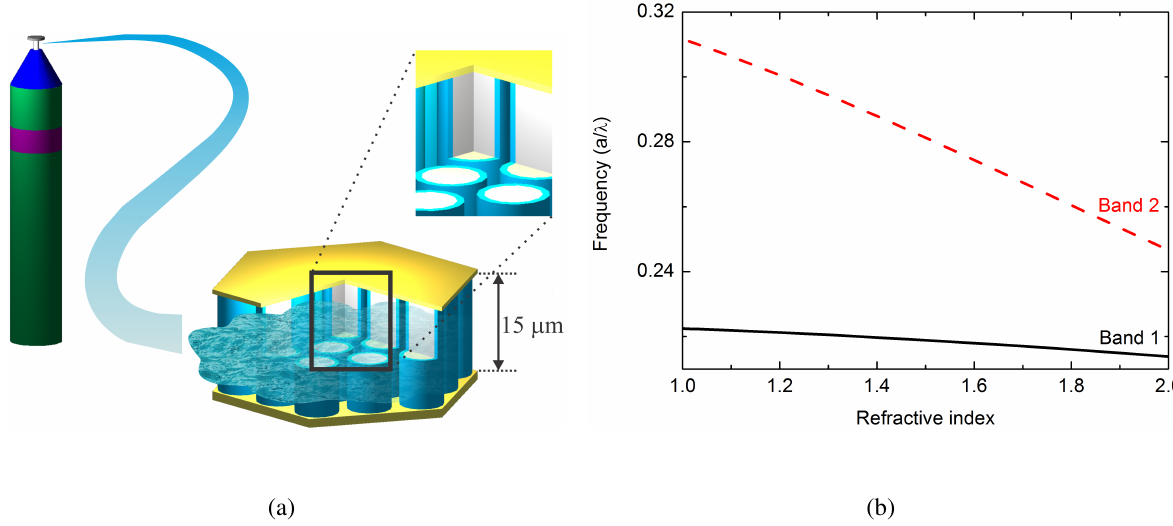
(a) Schematic of the active PhC sensor. The size of our resonator is comparable with passive microsensors in the visible [11]. The height is 15 µ m, the diameter around 200 µ m. (b) Resonance frequency shift for Band 1 and 2. Higher bands show a stronger effect of the resonance position on the refractive